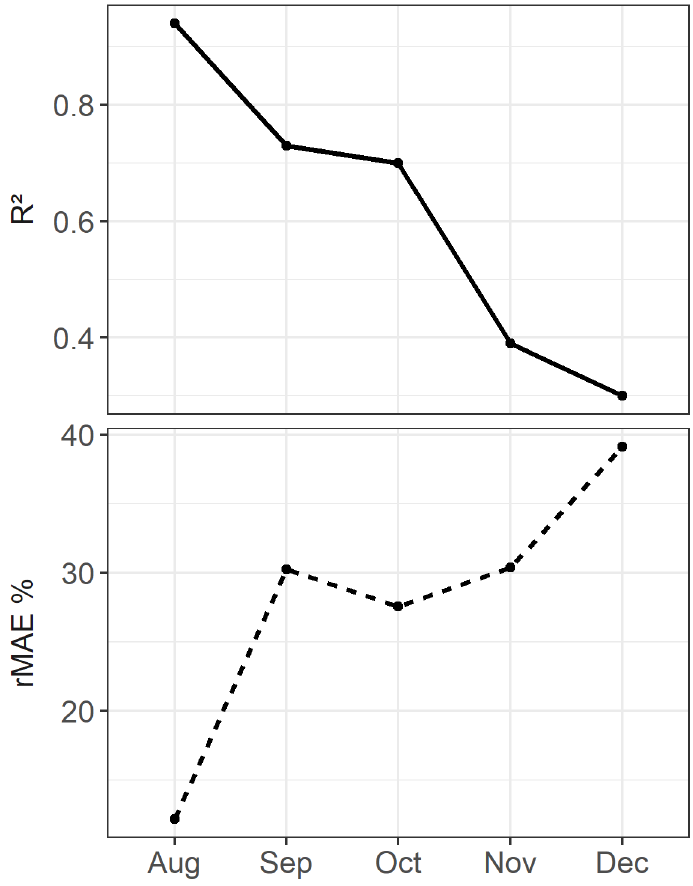
Figure 6. Values of R² and relative mean absolute error (rMAE) (%) of the universal SR red model predicting green area index (GAI) over a growth period of cover crops.